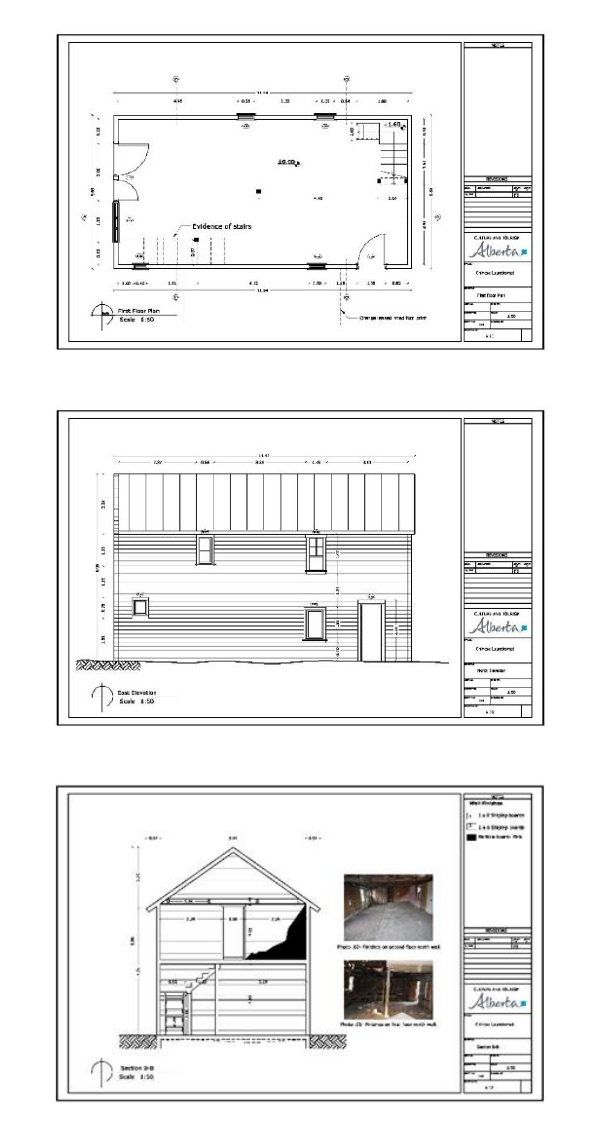
Figure 9: Examples of architectural plans created by Farzan Baradaran from the point cloud data. Source: Peter Dawson As Figure 10 vividly illustrates, the Quan Sang Lung Laundry